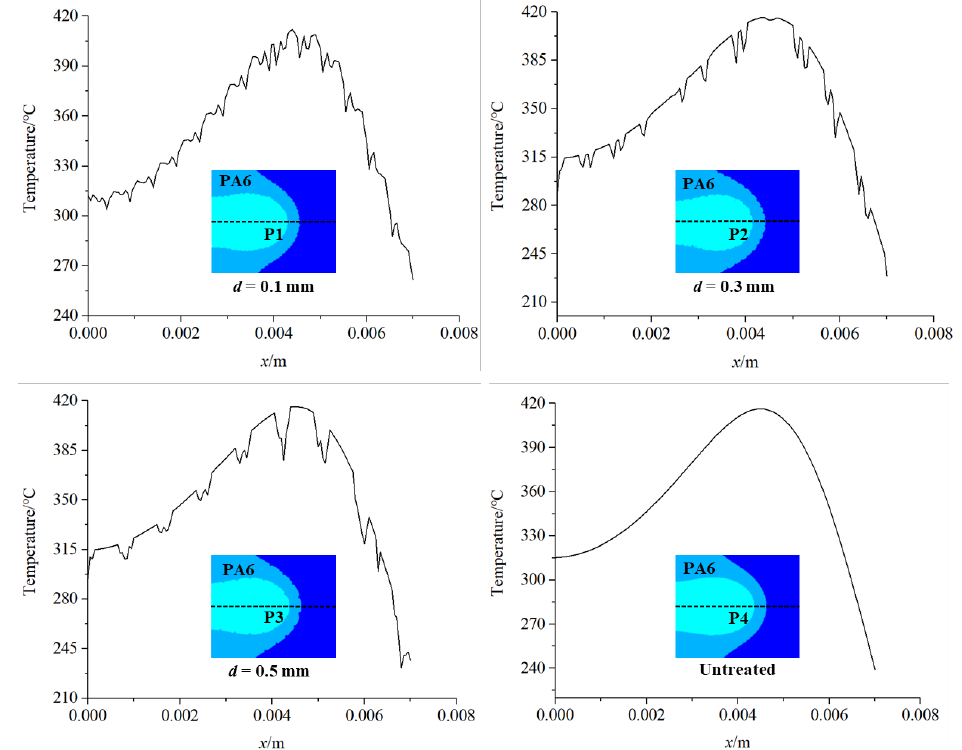
Figure 11. Comparison of PA6 interface temperature change.